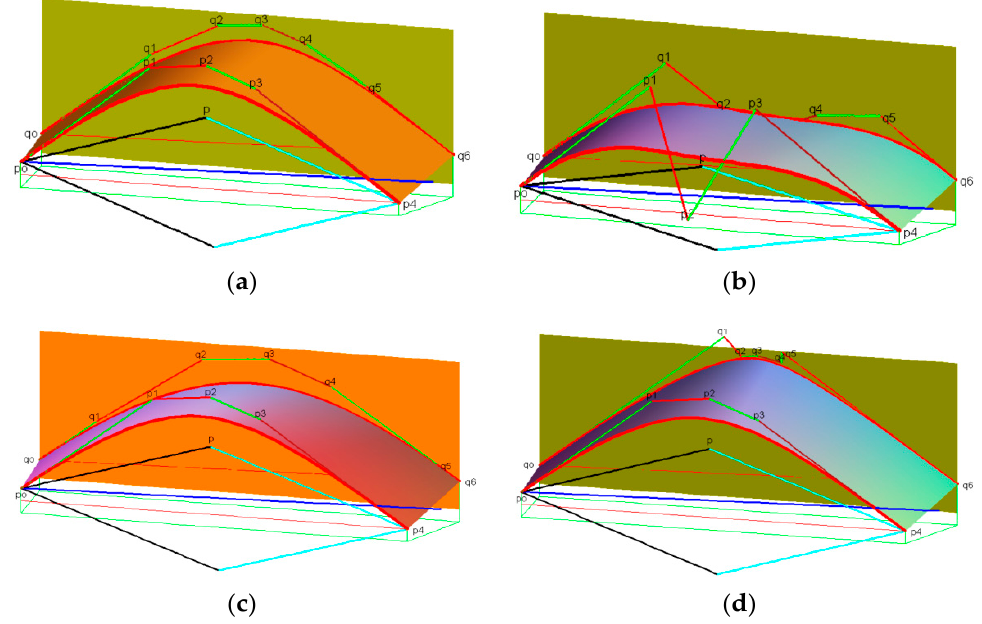
Figure 5. Construction [RDBP(4,6)] Q . ( a ) Value α 1 = 0; ( b ) Value α 1 = 0 and position p moved down; ( c ) Value α 1 = (0.6). w ; ( d ) Value α 1 = ( − 0.8). w .